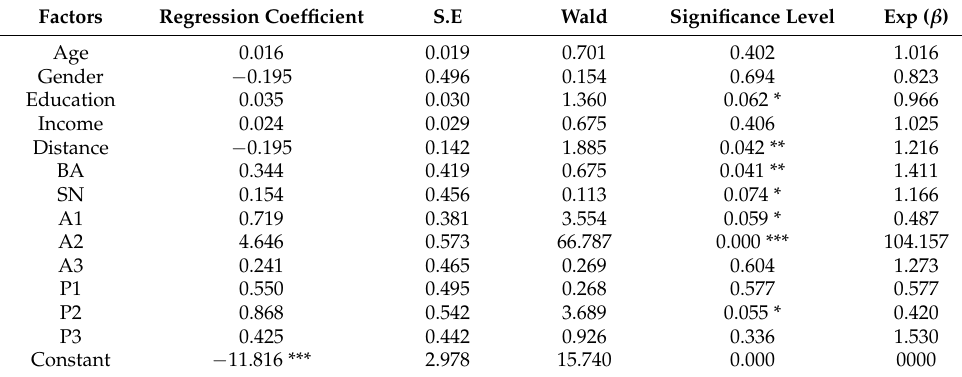
Table 6. Binary logistic regression analysis of farmers’ waste classification behavior. Factors Regression Coefficient S.E